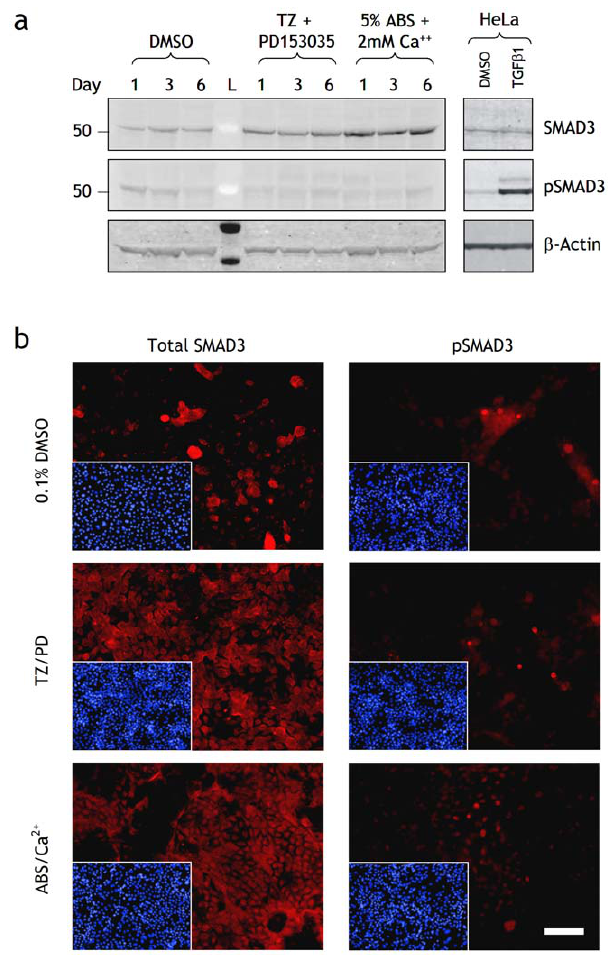
Figure 2. Effect of differentiation on SMAD3 and pSMAD3 protein expression in NHU cells. (a) Protein lysates were prepared from NHU cells treated with 0.1% DMSO (control), TZ/PD or ABS/Ca 2 + for 1, 3 and 6 days. Cell extracts (25 m g) were resolved on 4–12%